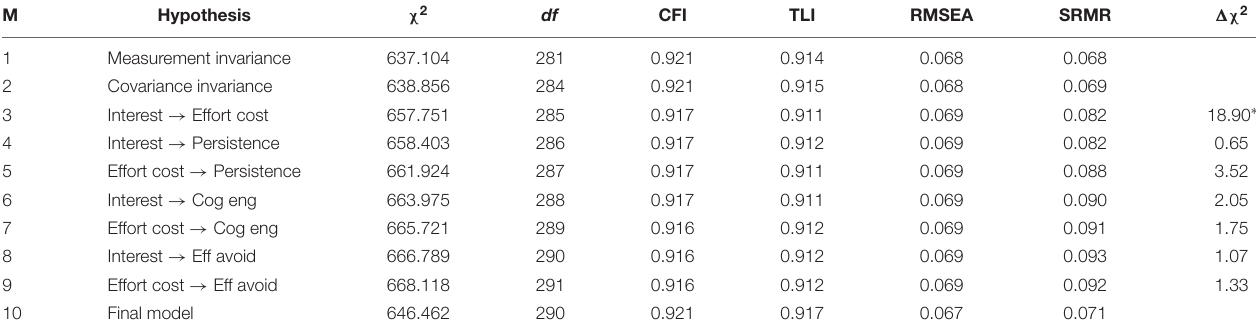
TABLE 6 | Model fit statistics for a multi-group analysis.